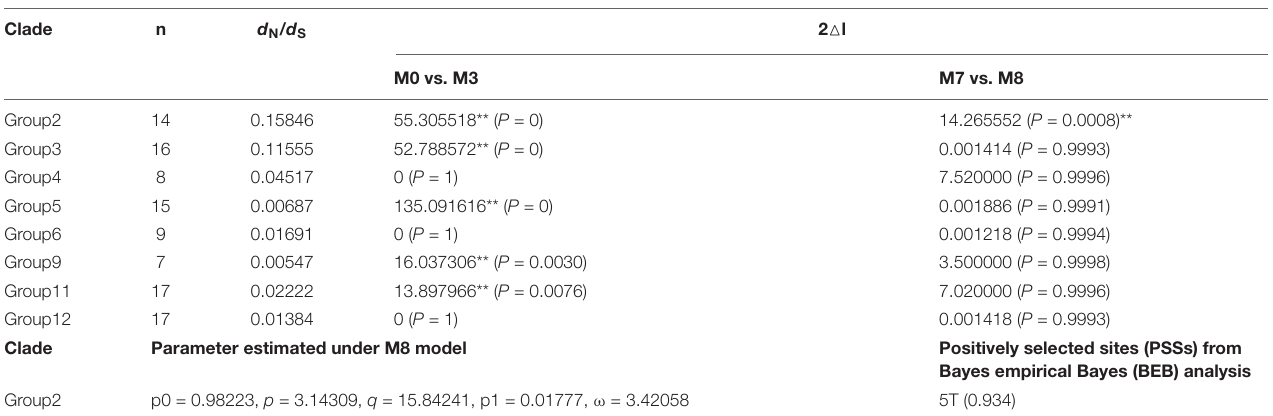
FIGURE 4 | Chromosomal distribution of OBP genes in C. pomonella (red) and B. mori (blue). Cyan solid lines represent the correspondence between C. pomonella and B. mori OBP genes. TABLE 1 | Tests of positive selection on the orthologous/paralogous OBP genes of moths by site